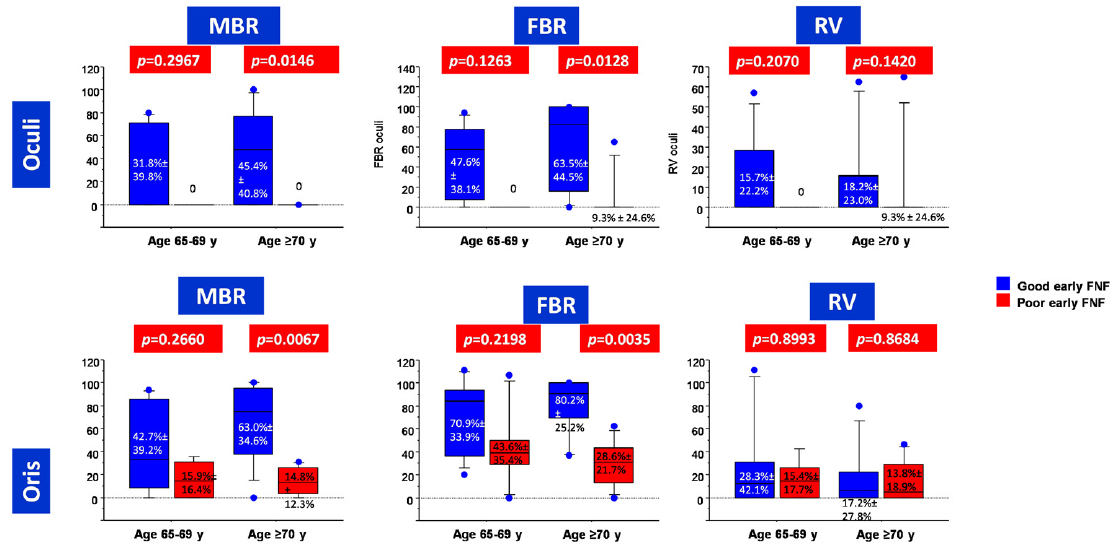
Figure 1. Box plots depicting corticobulbar FMEP indices depending on age and early post-operative FNF.